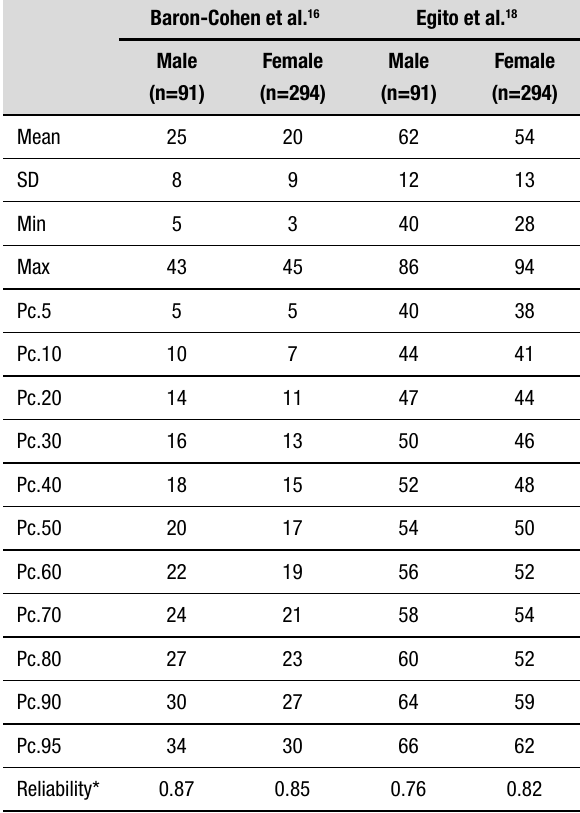
Table 1. Descriptive data of Autism Spectrum Quotient scores stratified by scoring method and